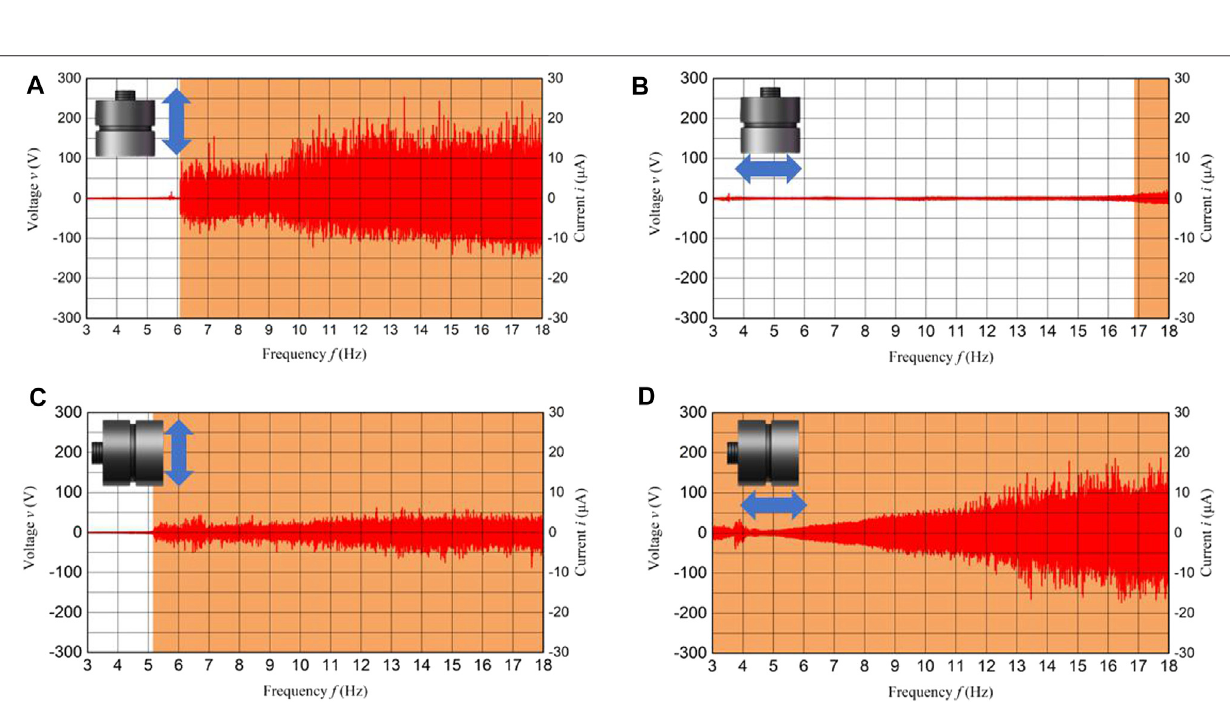
FIGURE 6 | Results of the inertial-force frequency-sweep test under 13 mm peak-to-peak excitation at 3 – 18 Hz sweep frequency: (A) Output voltage and current ofLM-FTGintheVVmode. (B) OutputvoltageandcurrentofLM-FTGintheVHmode. (C) OutputvoltageandcurrentofLM-FTGintheHVmode. (D) Outputvoltageand current of LM-FTG in the HH